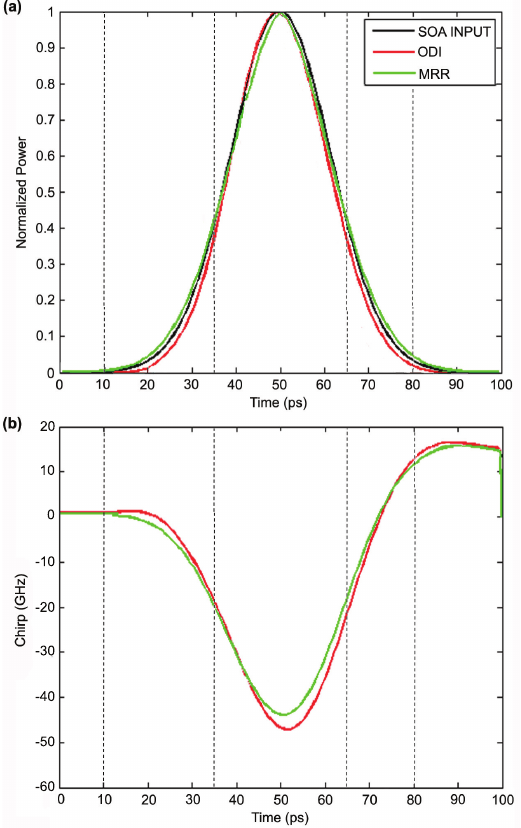
Figure 8. ( a ) Profile of isolated data pulse at ODI (red color) and MRR (green color) output in comparison to SOA input (black color). ( b ) Corresponding chirp profile at ODI (red color) and MRR (green